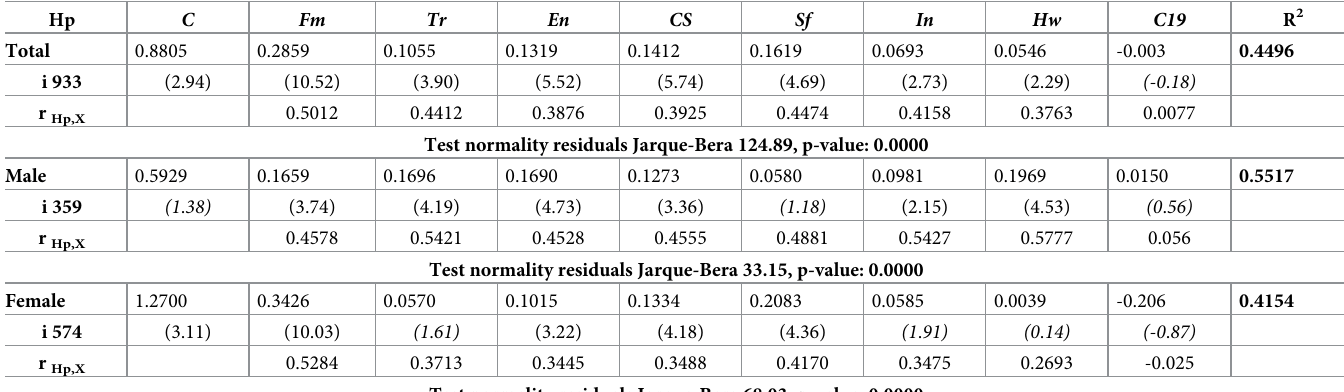
Table 3. Estimated relationship among happiness: General and by